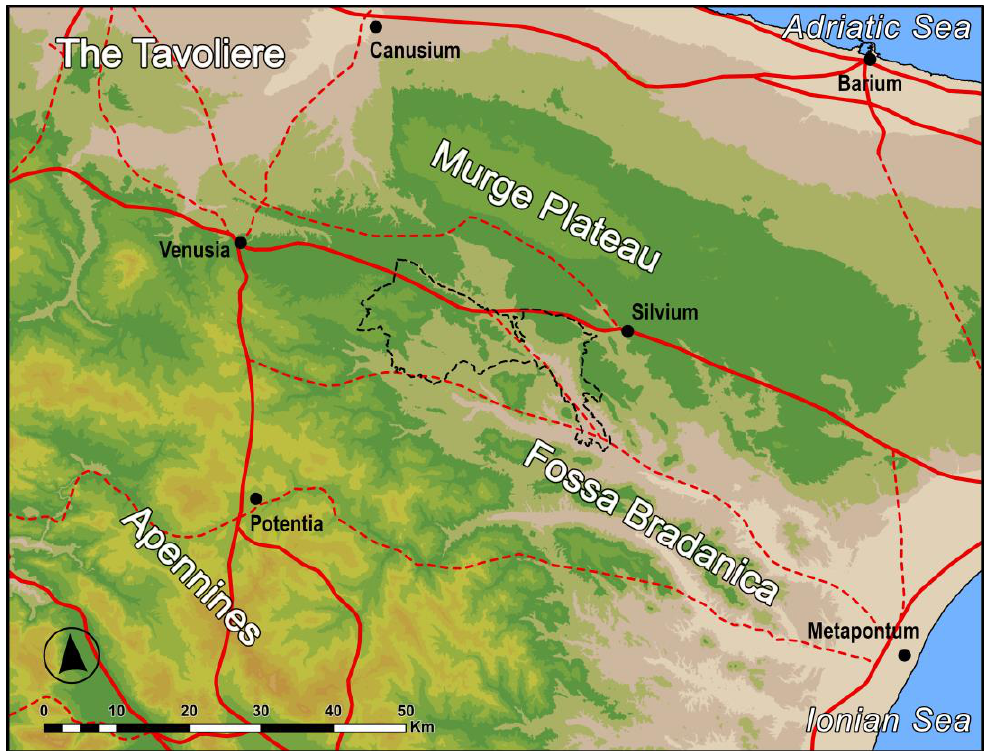
Figure 3. The survey area showing geographic features, the likely locations of major (solid) and minor (dashed) Roman roads, and nearby Roman towns.